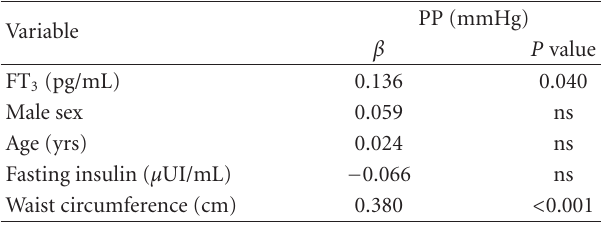
Table 6: Determinants of 24 h pulse pressure (PP) in the multiple linear regression